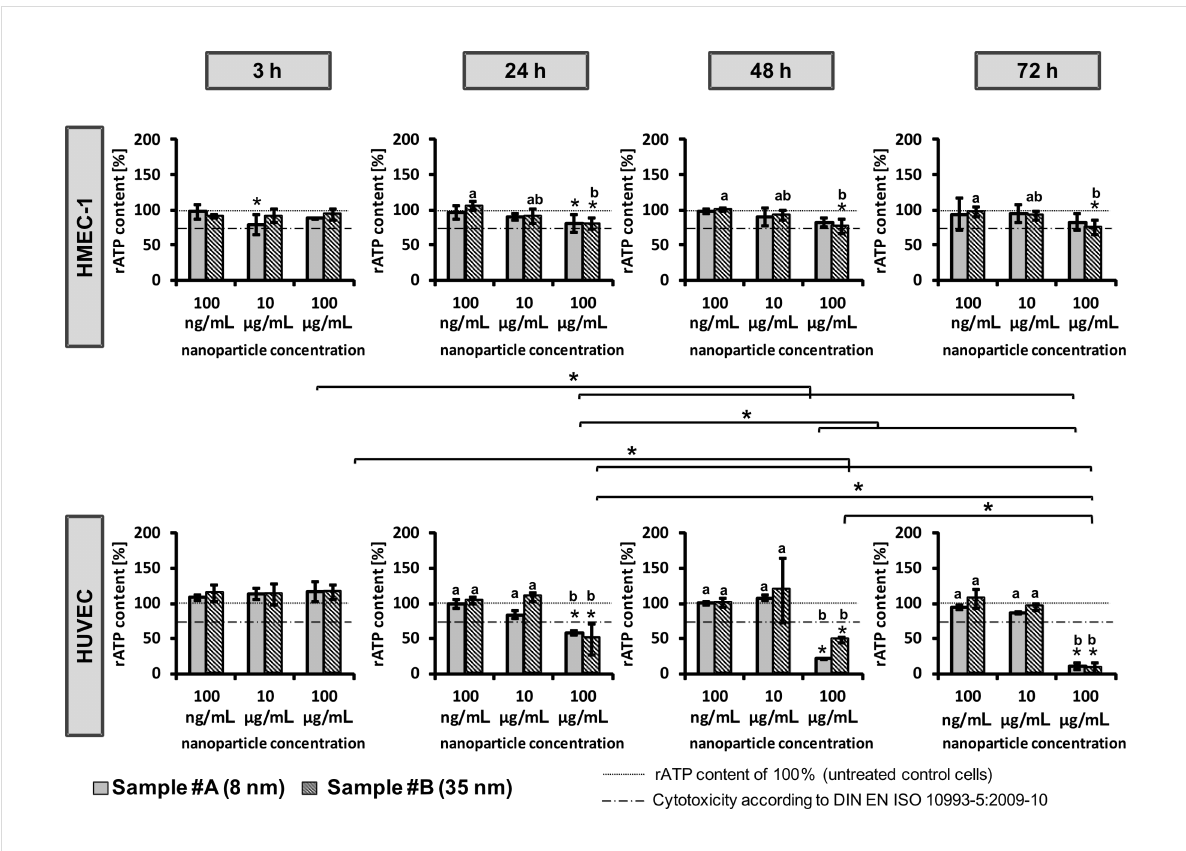
Figure 3: CeO 2 nanoparticles revealed concentration- and time-dependent effects on the cellular adenosine triphosphate (ATP) level. Immortalized human microvascular endothelial cells (HMEC-1) and primary human macrovascular endothelial cells (HUVEC) were exposed to CeO 2 nanoparticles of different sizes (sample #A (8 nm), sample #B (35 nm)), concentrations, and incubation times (3 h, 24 h, 48 h, 72 h). rATP content: relative ATP content; n = 3 independent experiments; *single asterisks over the bar indicate significant differences (P ≤ 0.05) between the relative ATP content of cells after treatment with the corresponding nanoparticle concentration and the relative ATP content of 100% (untreated control cells); a, b, c indicate significant differences (P ≤ 0.05) of one nanoparticle formulation among different concentrations; *asterisks, which are together with a parenthesis, indicate significant differences (P ≤ 0.05) between time points for a specific concentration of one nanoparticle